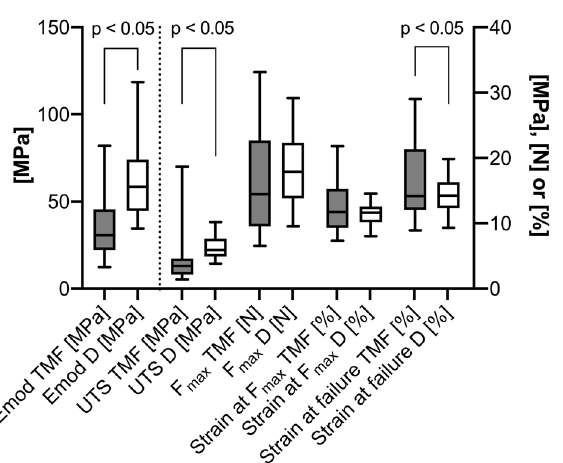
Figure 4. The biomechanical parameters of native temporal muscle fascia (TMF) and an age-matched group of dura mater (D) samples are displayed. The outlines of the boxes indicate the 25% and 75% percentile, the solid black line within the boxes represents the median. Whiskers indicate the minimum and maximum. The dotted line separates left and right y-axis. Emod, elastic modulus; F max , maximum force; S failure , strain at failure; SF max , strain at maximum force; UTS, ultimate tensile strength; * values taken from Zwirner et al. 2019 21 .